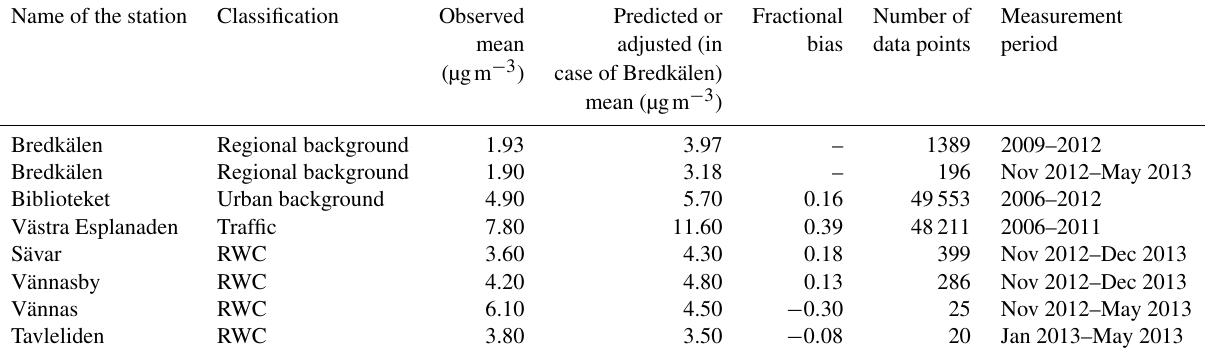
Table C1. Selected statistical parameters for the agreement of predictions and measurements for the daily concentrations of PM 2 . 5 in the Umeå area. The measured values at the station of Bredkälen have been adjusted slightly based on regional-scale dispersion model computations. For Bredkälen, the results for two different periods have been separately presented.